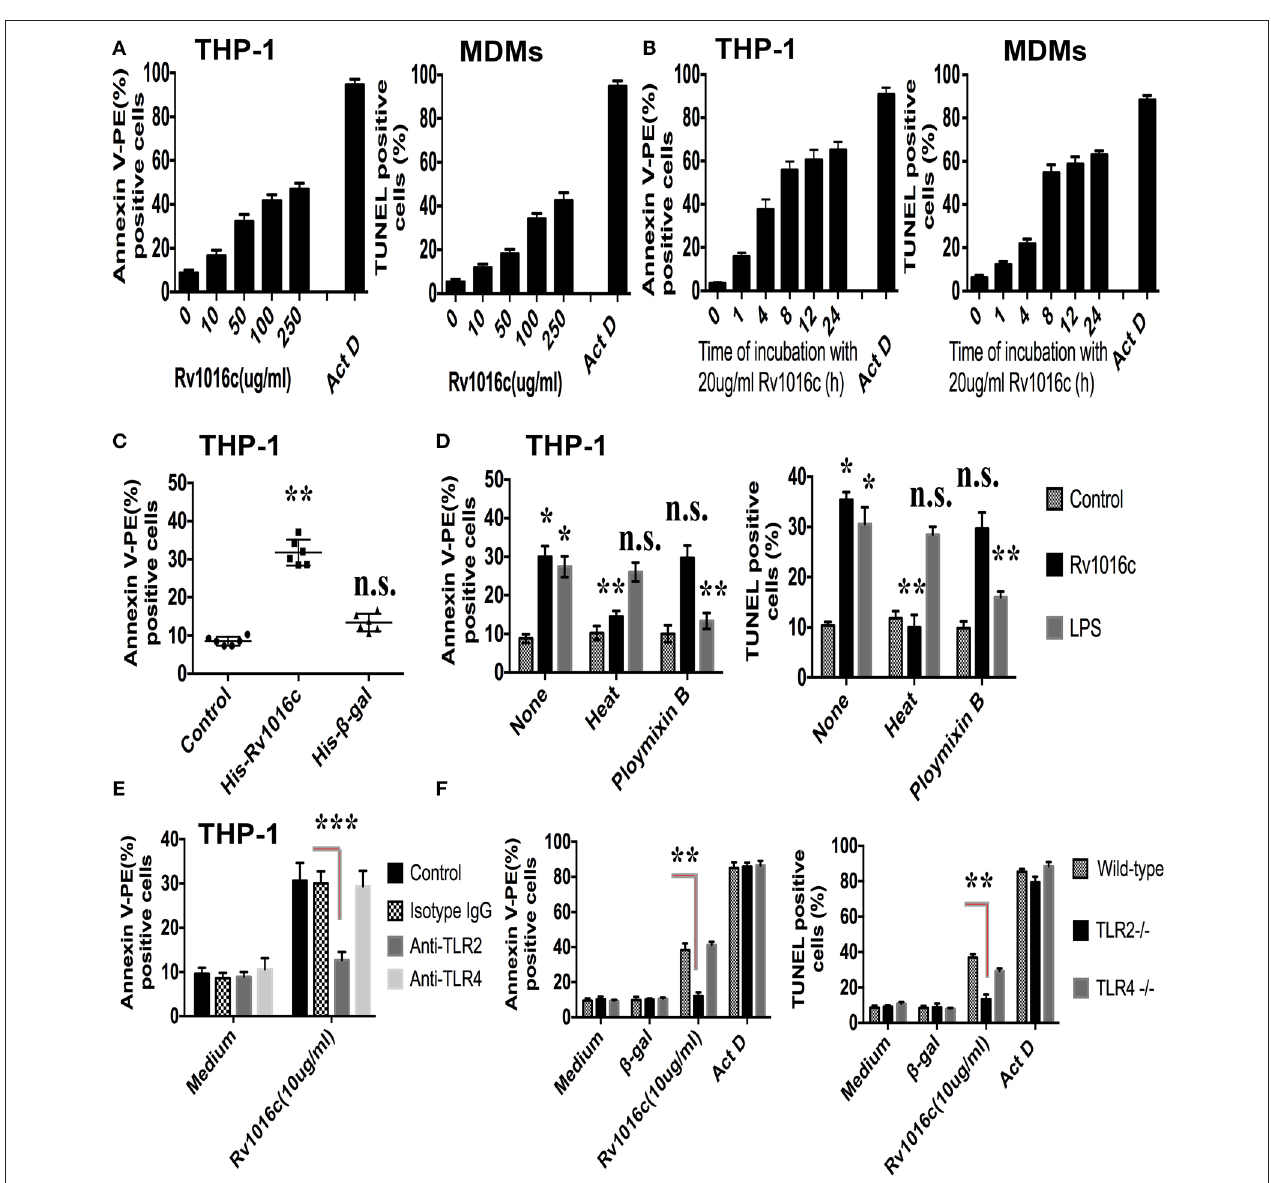
FIGURE 4 | Rv1016c induces apoptosis through TLR2 in macrophages. THP-1 cells or monocytes derived macrophages (MDMs) were incubated with either a range of concentrations of Rv1016c for 2 h (A) or for varying lengths of time with 20 µ g/ml recombinant protein (B). Apoptosis was analyzed by flow cytometry or TUNEL assay. Actinomycin D was used as a positive control for apoptosis. (C) Apoptosis induced by Rv1016c is not due to His tag. THP-1 cells were incubated with equal amounts of His-tagged β -galactosidase (as control for specificity) or His-tagged Rv1016c. Apoptosis was analyzed by flow cytometry. (D) Apoptosis induced by Rv1016c is not due to LPS contamination. THP-1 cells were incubated with recombinant Rv1016c or LPS. Before addition to cells (20 µ g/ml for 2 h), His-tagged Rv1016c was either subjected to boiling for 1 h or treated with polymyxin B resin. For the latter, 100 µ l of polymyxin bead slurry was added to 100 µ l of recombinant Rv1016c preparation and incubated at 4 ◦ C for 1 h. After centrifugation, the supernatant was used for apoptosis induction analyzed by flow cytometry or TUNEL assay. (E) THP-1 cells were incubated with Isotype Ig G (30 µ g/ml), Anti-TLR2 blocking Abs (30 µ g/ml) or Anti-TLR4 blocking Abs (30 µ g/ml) for 18h, followed by treated with 20 µ g/ml recombinant Rv1016c for 2 h. Apoptosis was analyzed by flow cytometry. (F) Macrophages derived from C57BL/6, TLR2 − / − , and TLR4 − / − mice were incubated with Rv1016c-His (20 µ g/ml) for 2 h, and then apoptosis was analyzed flow cytometry or TUNEL assay. Incubation of cells with actinomycin D or Histagged β -galactosidase was used as a control for apoptosis. All data were generated from three independent experiments and Data are shown as Means ± SD of triplicate wells. (* p < 0.05, ** p < 0.01, *** p < 0.001 vs. corresponding